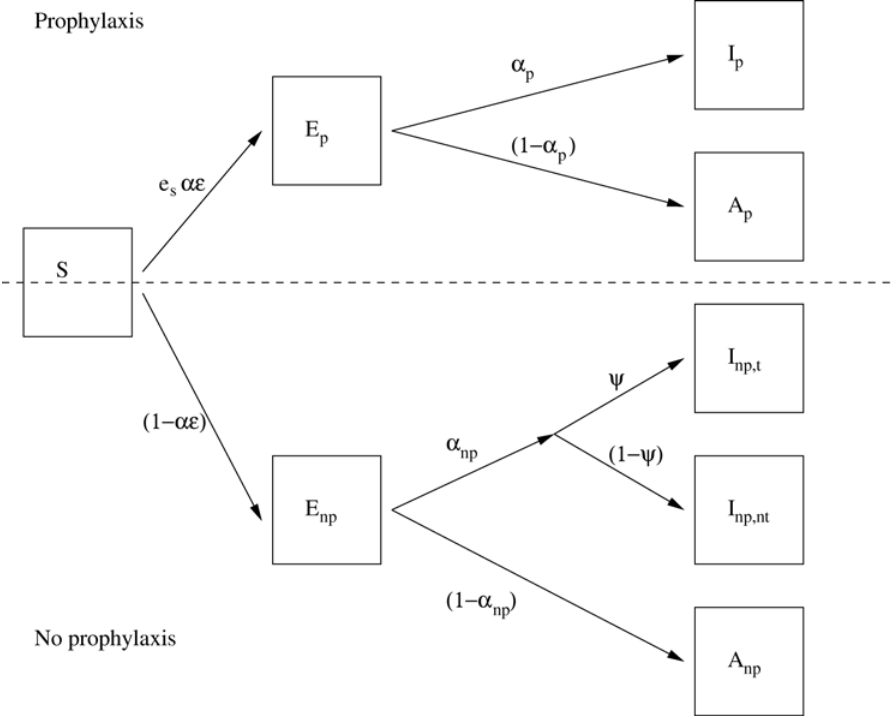
Figure 1. Model schematic. Simplified schematic of the model in the case of no resistance. In the steady state a proportion, e , of contacts of symptomatic cases who are susceptible will have received prophylaxis ( p subscript, above the dotted line). The remainder have not ( np subscript, below the dotted line). Those on prophylaxis have a reduced susceptibility e s . For details refer to [1]. A proportion, y , of symptomatic infections that were not provided with prophylaxis receive treatment. For clarity, we have not shown the progression from the infectious ( I , A ) states to the permanently recovered ( R ) states. The force of infection arises from the five states on the right. Relative to the I np , nt state, the infectiousness of the I p , A p , I np , t and A np states are reduced by the factors e i , e i x , e t and x respectively.